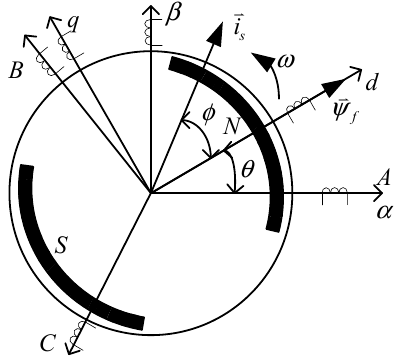
Figure 5. Schematic diagram of winding relationship in different coordinate systems.